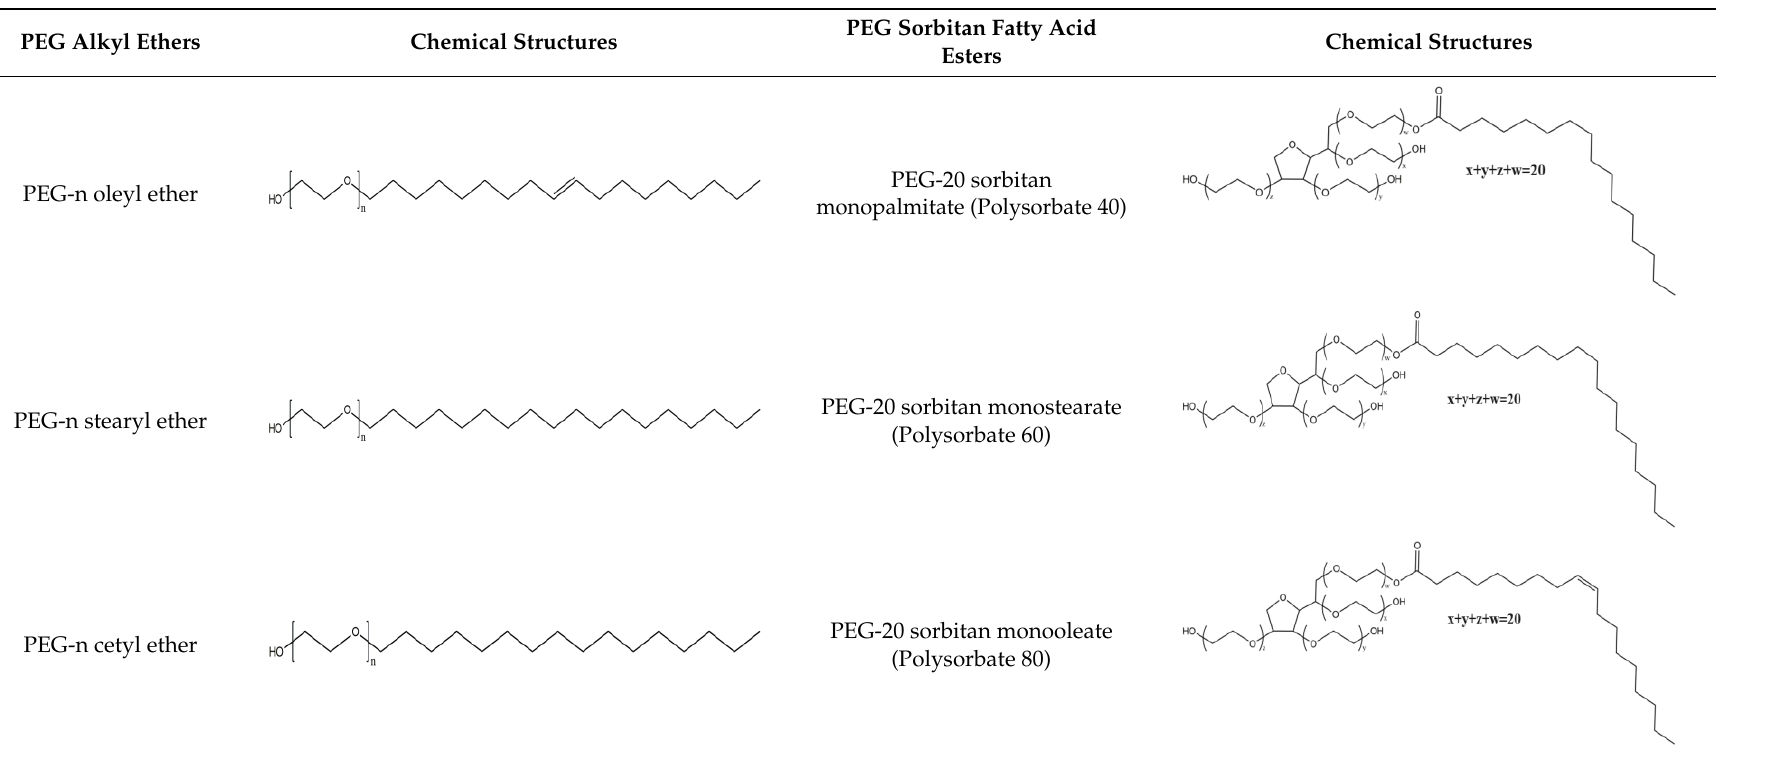
Table 2. Chemical structures of PEG alkyl ethers and PEG sorbitan fatty acid esters.